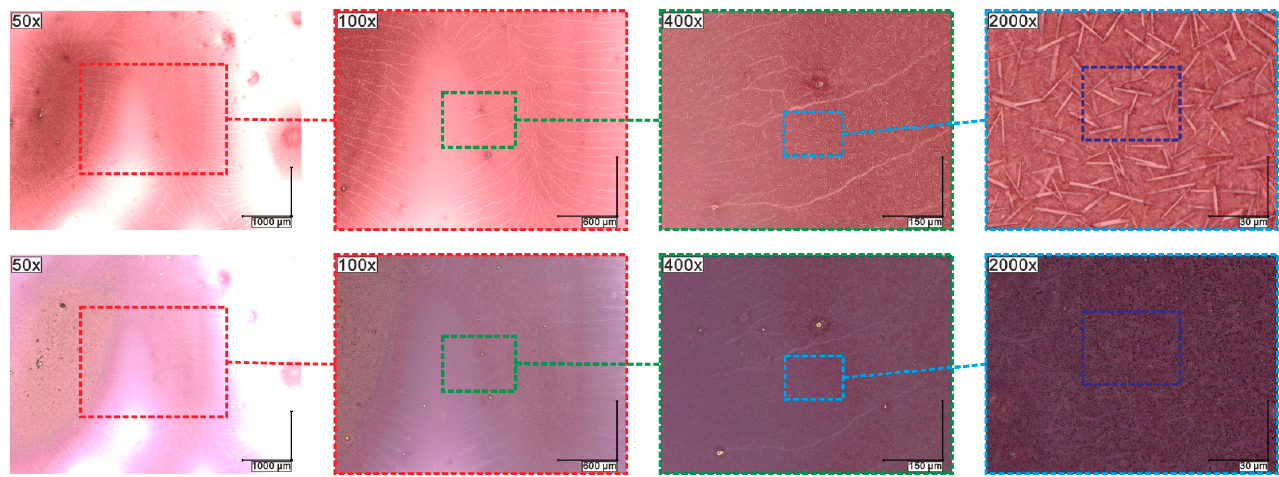
Figure 7. Room temperature digital optical images with ring illumination for pristine Au nanopar- ticles ( upper row ) and cooled to room temperature after being heated to 155 °C and kept at this temperature for 5 min ( bottom row ). The colored dotted squares represent the enlarged areas.